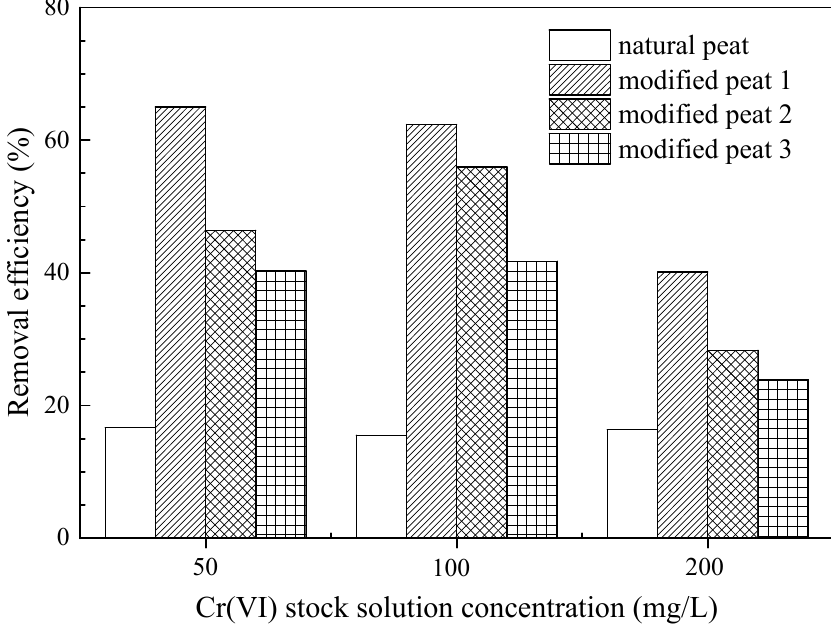
Figure 1. Chromium removal efficiency of modified peat using different methods. (The conditions were as follows: pH of 6, peat dose of 10 g/L, room temperature.).